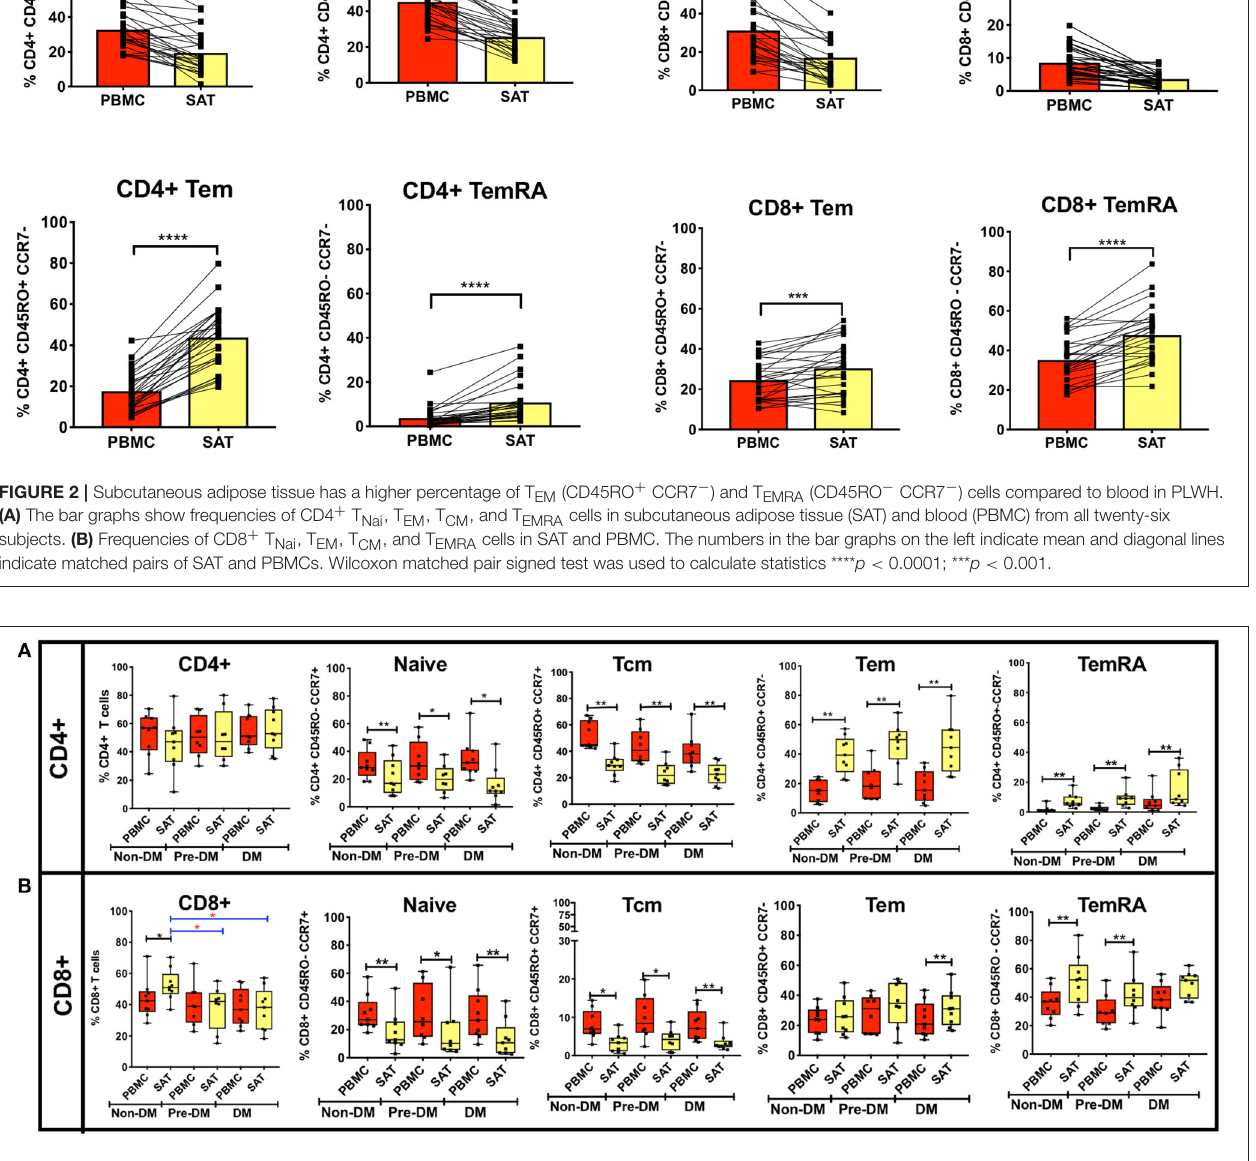
FIGURE 3 | Analysis of CD4 + and CD8 + memory subsets by metabolic status in PLWH. (A) The bar graphs on the top row show frequencies of CD4 + T Nai , T EM , T CM , and T EMRA cells in subcutaneous adipose tissue (SAT) and blood (PBMC) from all twenty six PLWH. Participants are grouped based on glucose tolerance: non-diabetic (Non-DM): hemoglobin A1c < 5.7% and fasting glucose < 100 mg/dL ( n = 9); Pre-DM: hemoglobin A1c 5.7–6.4% or fasting glucose 100–125 mg/dL ( n = 8); DM: hemoglobin A1c > 6.5% and/or fasting glucose > 126 mg/dL, and on anti-diabetes medication ( n = 9). (B) Frequencies of CD8 + T Nai , T EM , T CM , and T EMRA cells in SAT and PBMC. The box and whiskers plot indicate mean ± SD. Wilcoxon matched pair signed test was used to calculate statistics between matched PBMC and SAT T cells, Mann-Whitney test was used to analyze differences in SAT and PBMC T cell subsets between metabolic groups; ** p < 0.01, * p <